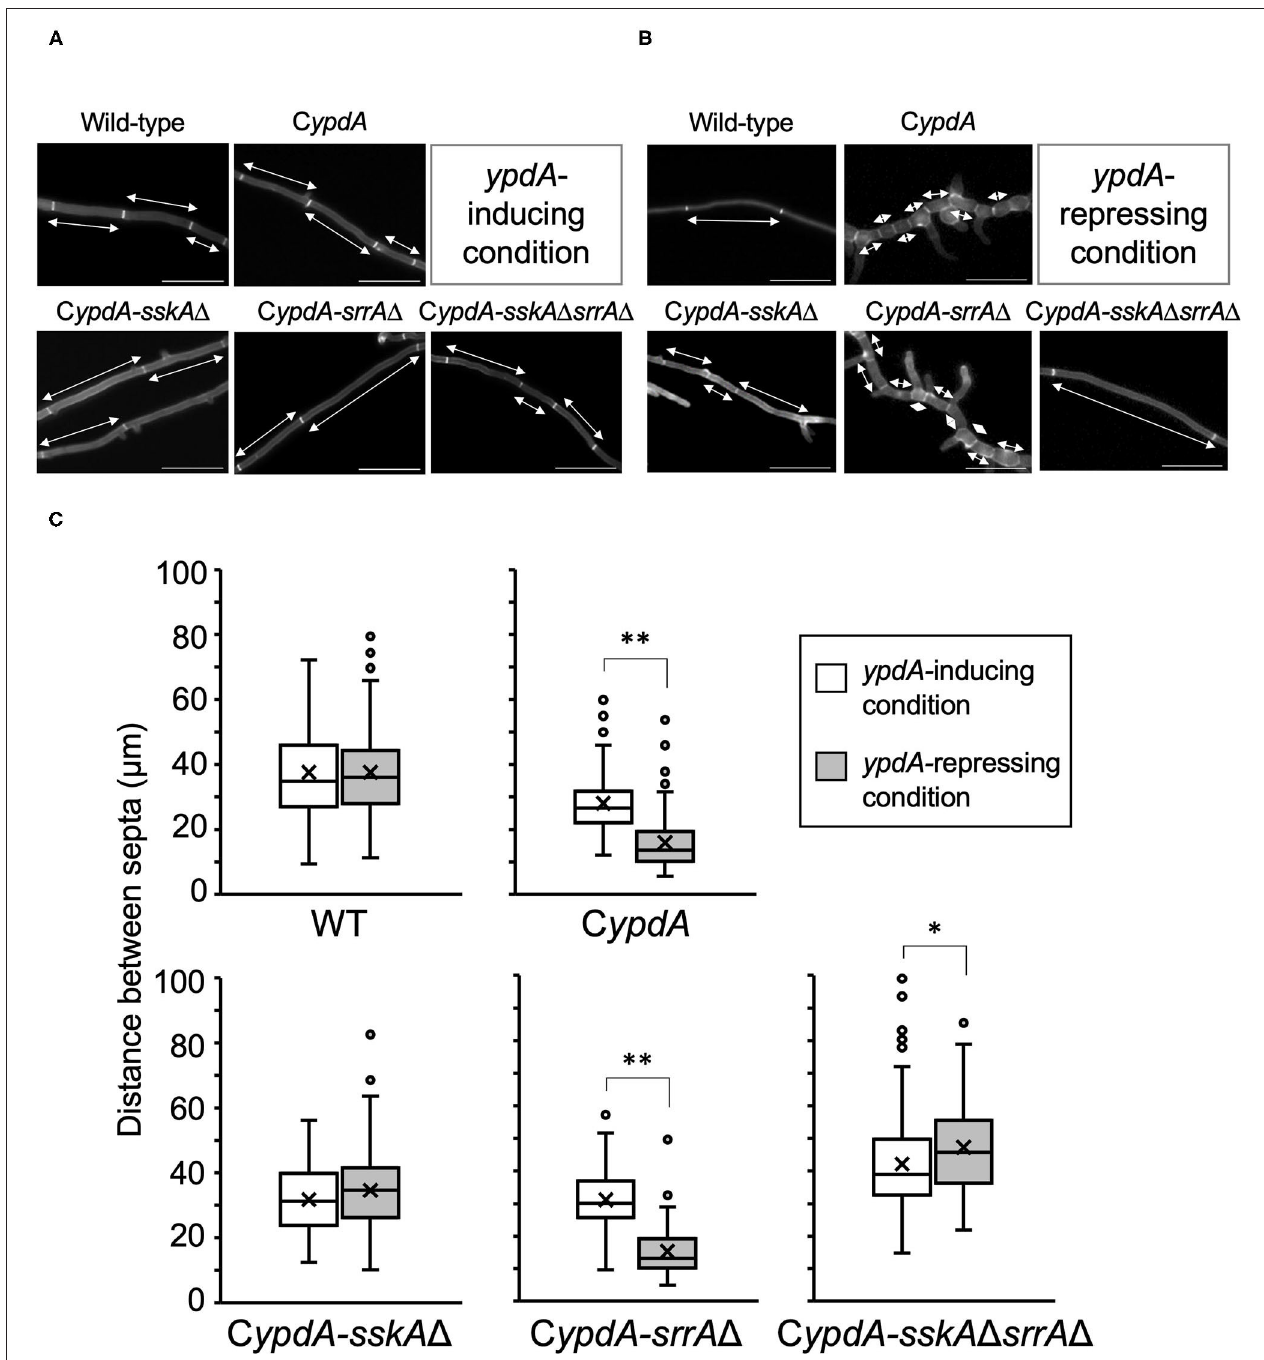
FIGURE 5 | Hyphal morphology (A,B) and distance between septa (C) of the wild-type, C ypdA , and its derivative strains under ypdA -inducing and -repressing conditions. Each strain was cultured in liquid ypdA -inducing CDTFY (A) or ypdA -repressing CDY (B) medium and stained with Calcofluor White. Double-headed arrows indicate distance between septa. Scale bars, 35 µ m. (C) White and gray boxes indicate the distribution of distances between septa under the ypdA -inducing and ypdA -repressing conditions, respectively. Lines in boxes indicate medians, and crosses indicate averages. White circles indicate outliers. Error bars represent the range of maximum and minimum values excluding the outliers. * P < 0.05, ** P < 0.01; Welch’s t -test.